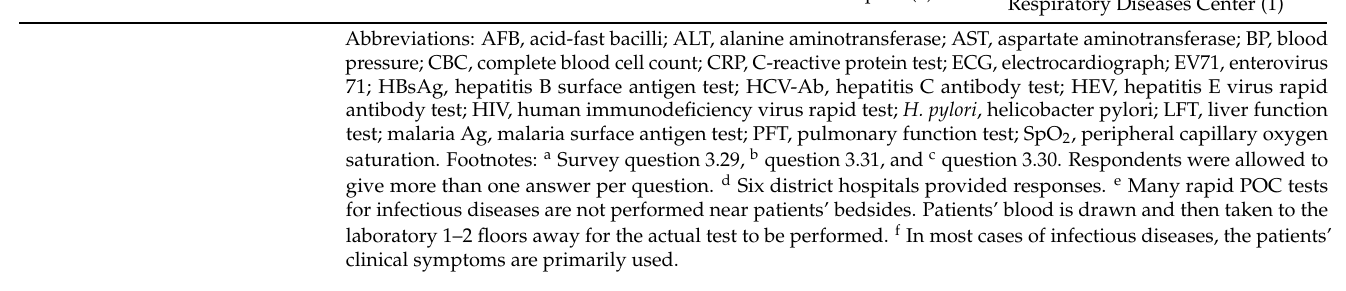
Table 3. Medical problems in Central Vietnam hospitals and